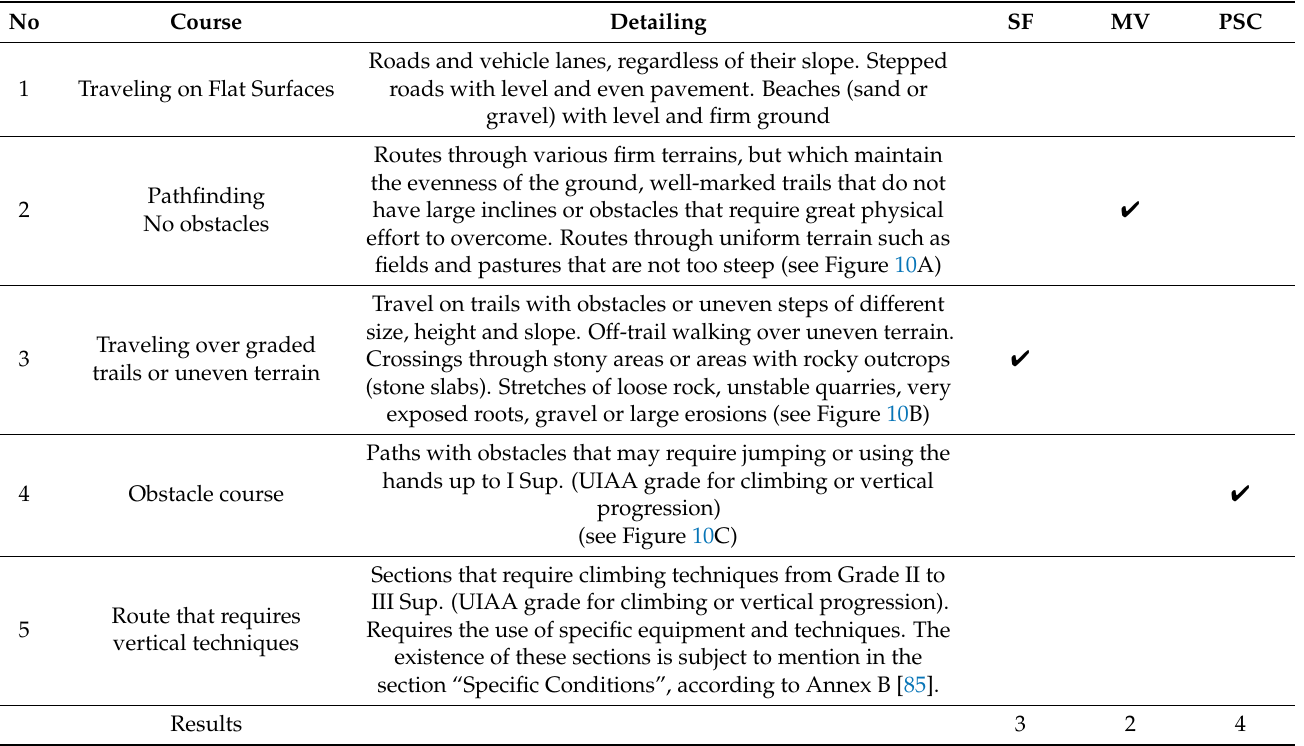
Table 6. Classification according to surface and ground conditions.